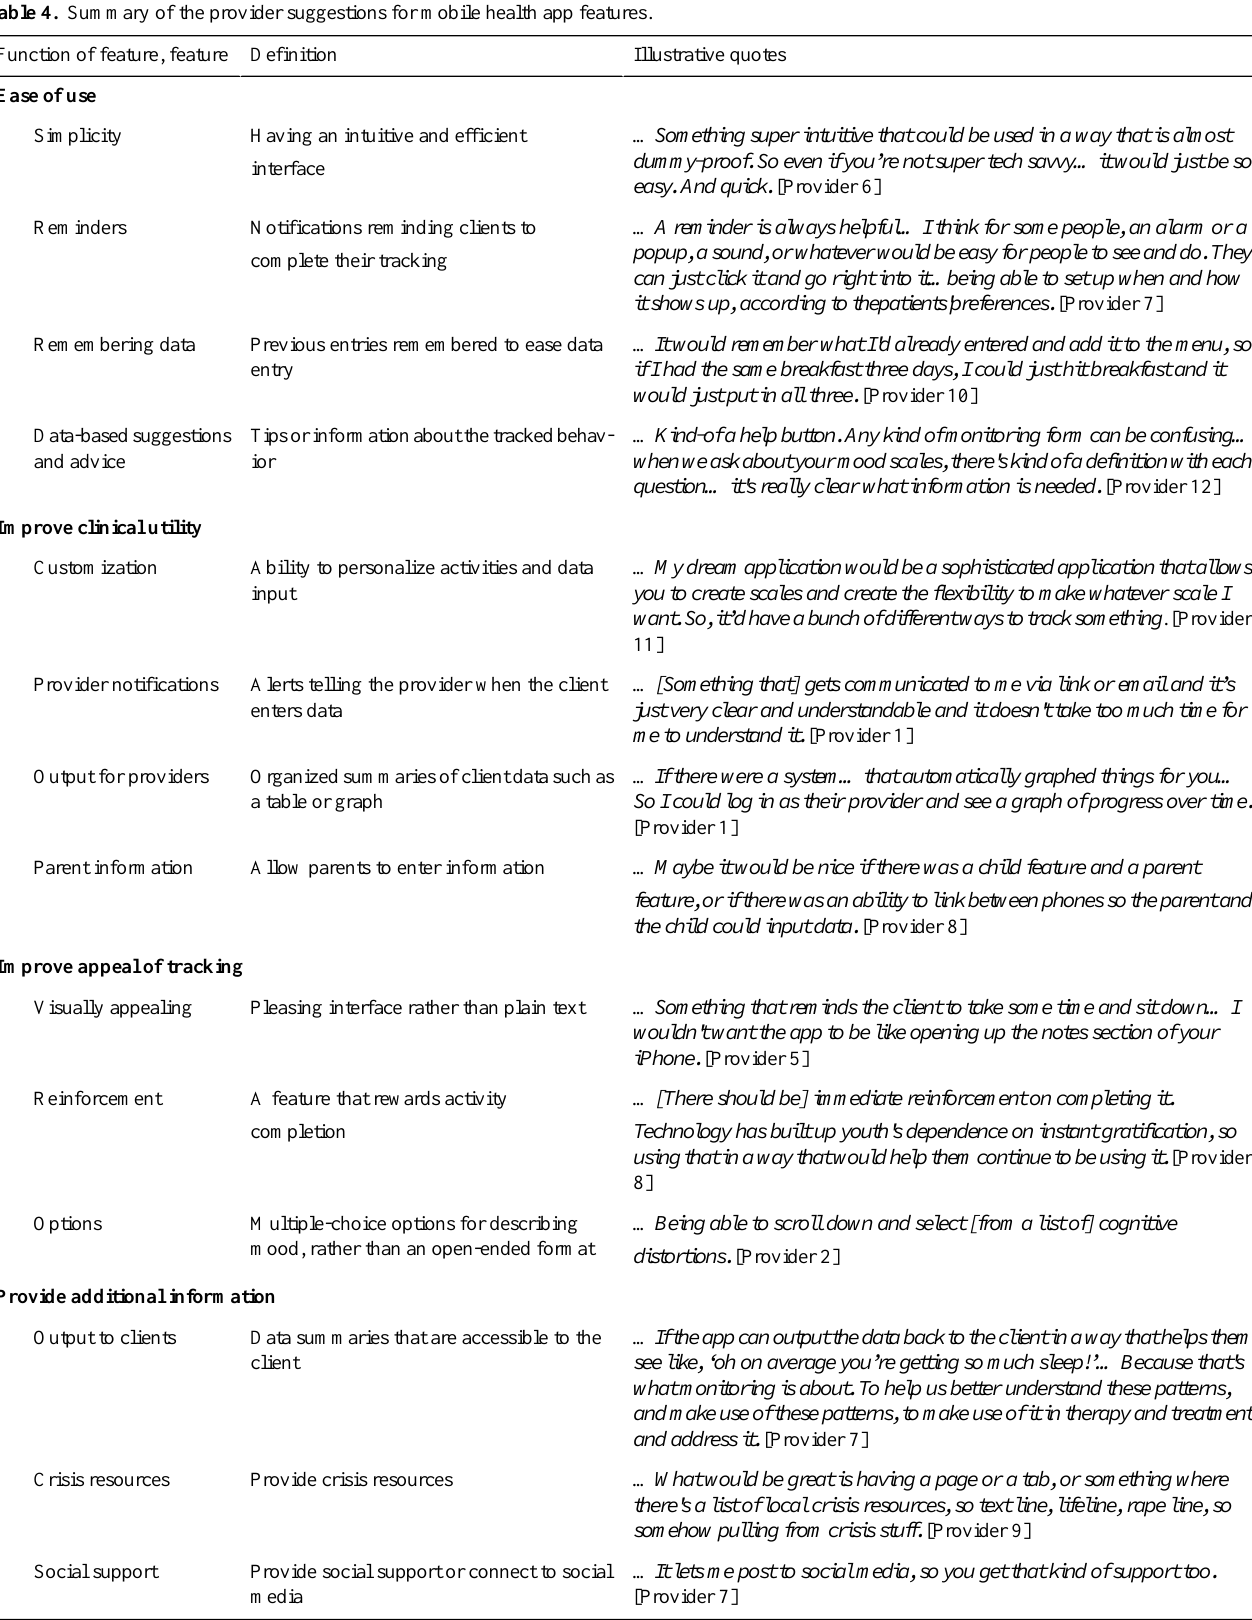
Table 4. Summary of the provider suggestions for mobile health app features.